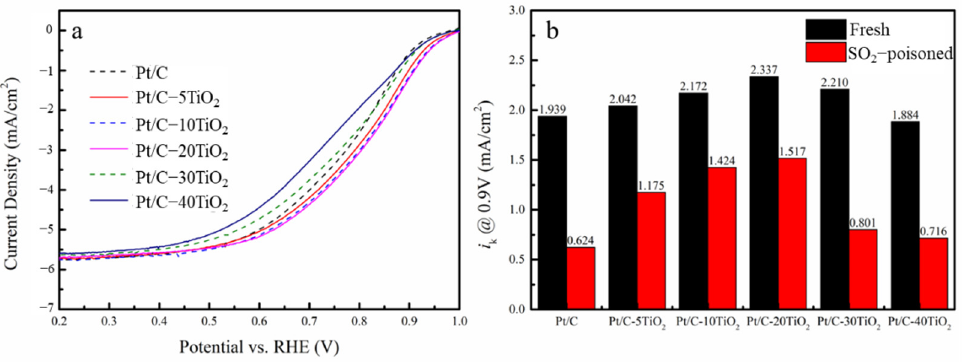
Figure 5. ( a ) The LSV ORR curves of SO 2 poisoned catalysts; ( b ) the kinetic current density at 0.9 V of fresh and SO 2 − poisoned catalysts.